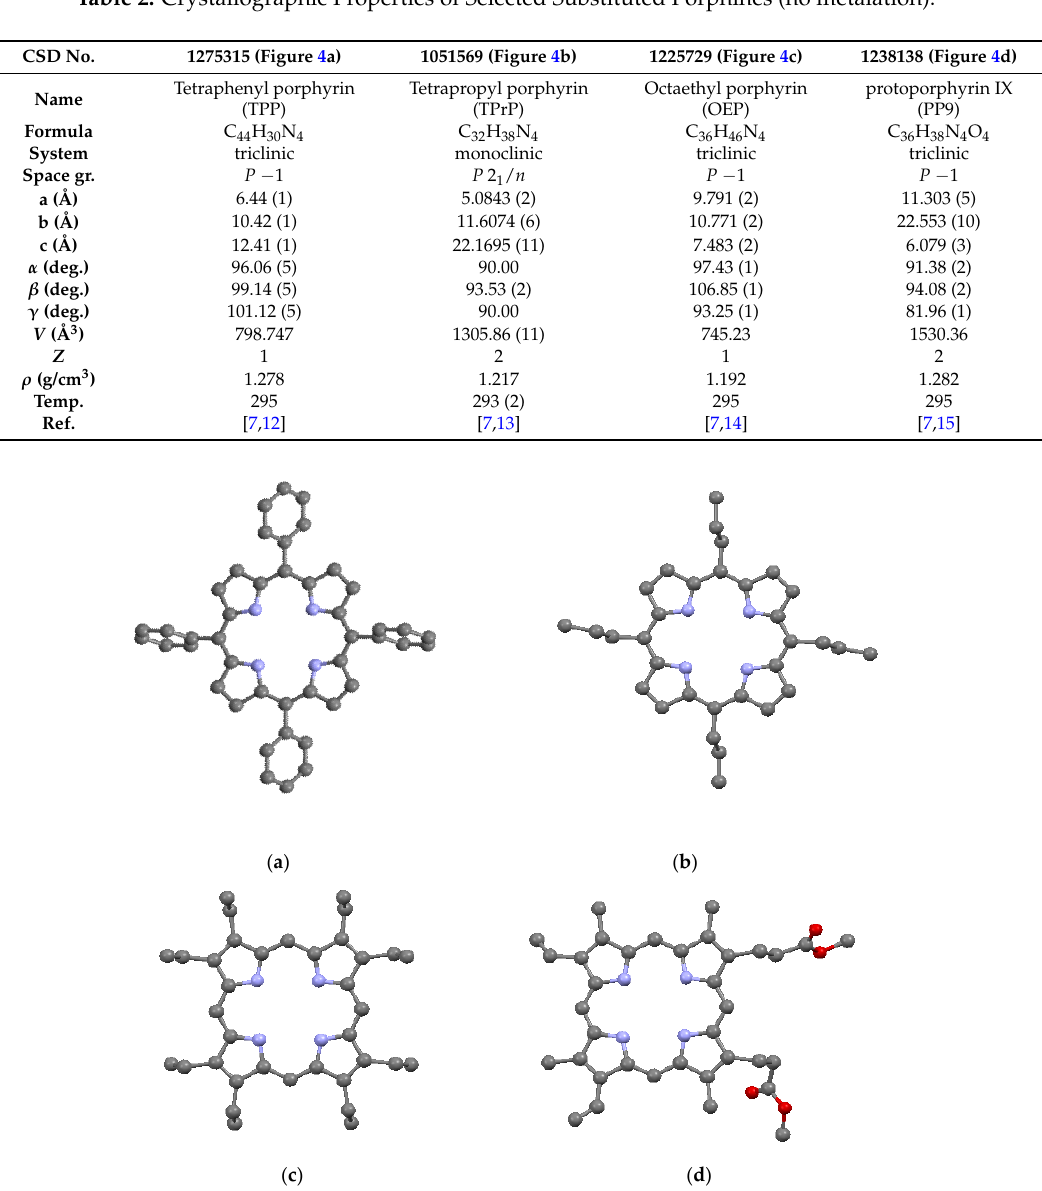
Table 2. Crystallographic Properties of Selected Substituted Porphines (no metalation).